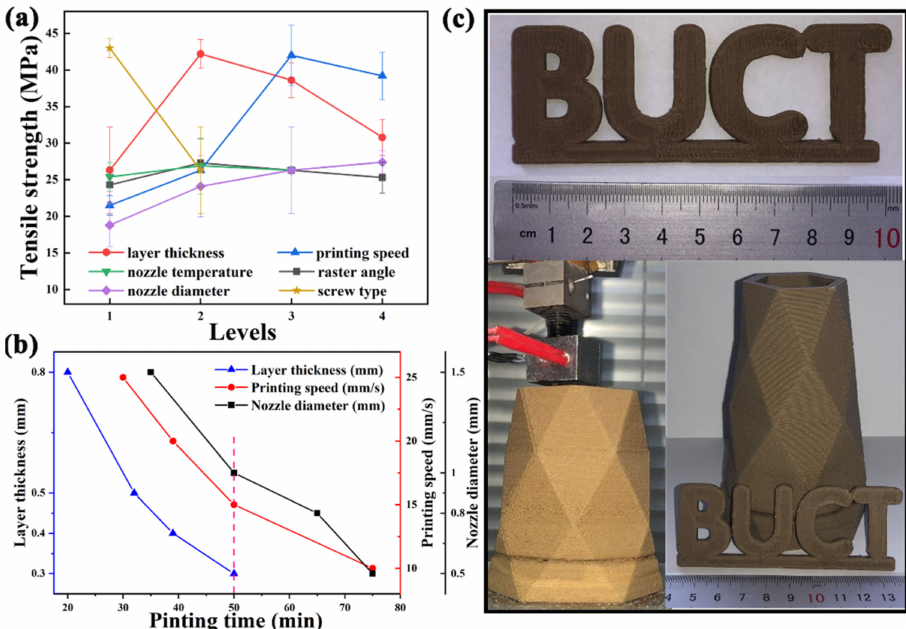
Figure 13. ( a ) Tensile strength curves and ( b ) Printing time curves of samples printed at various effect parameters. ( c ) Printed